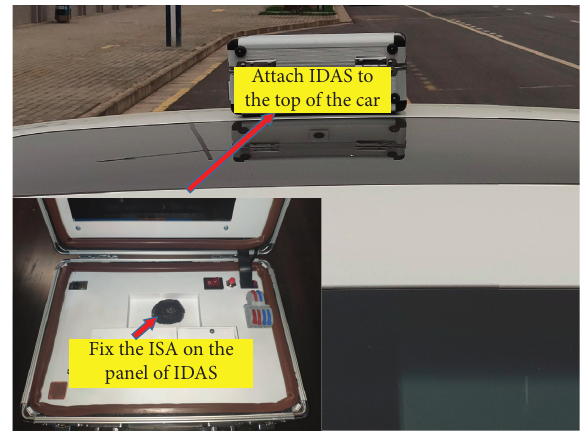
Figure 13: The test scenario of the Driving Perception Index (DPI). Table 9: The classification standard of IRI.